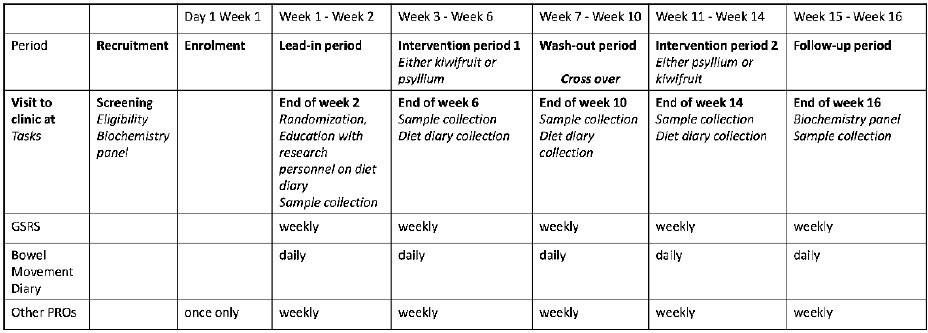
Figure 1. Study flow –